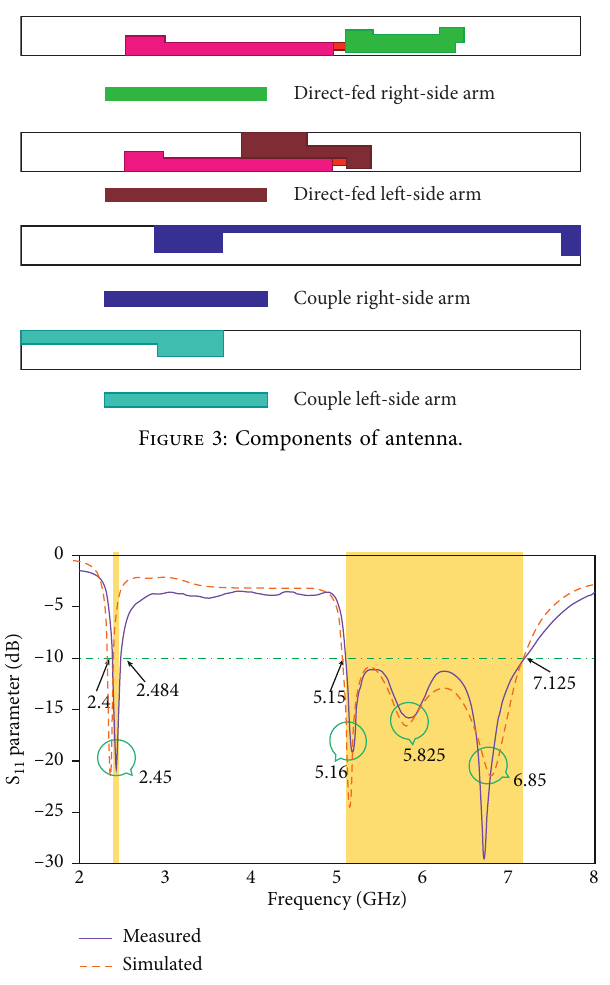
Figure 4: S 11 values derived from simulation and